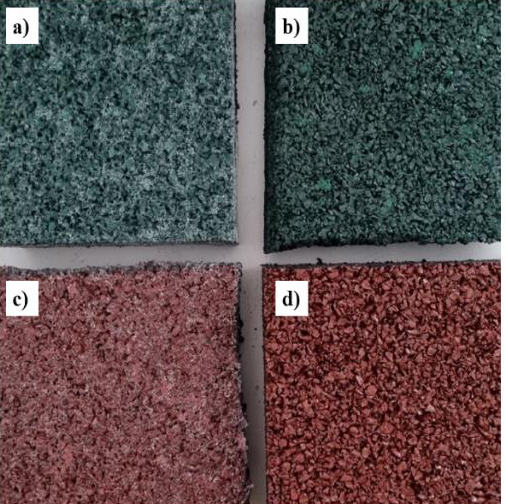
Figure 11. Surface comparison of referent rubber with sol – gel immobilized substrates: ( a ) green substrate with 2 g of TiO 2 , ( b ) referent green substrate, ( c ) red substrate with 2 g of TiO 2 , and ( d ) referent red substrate.